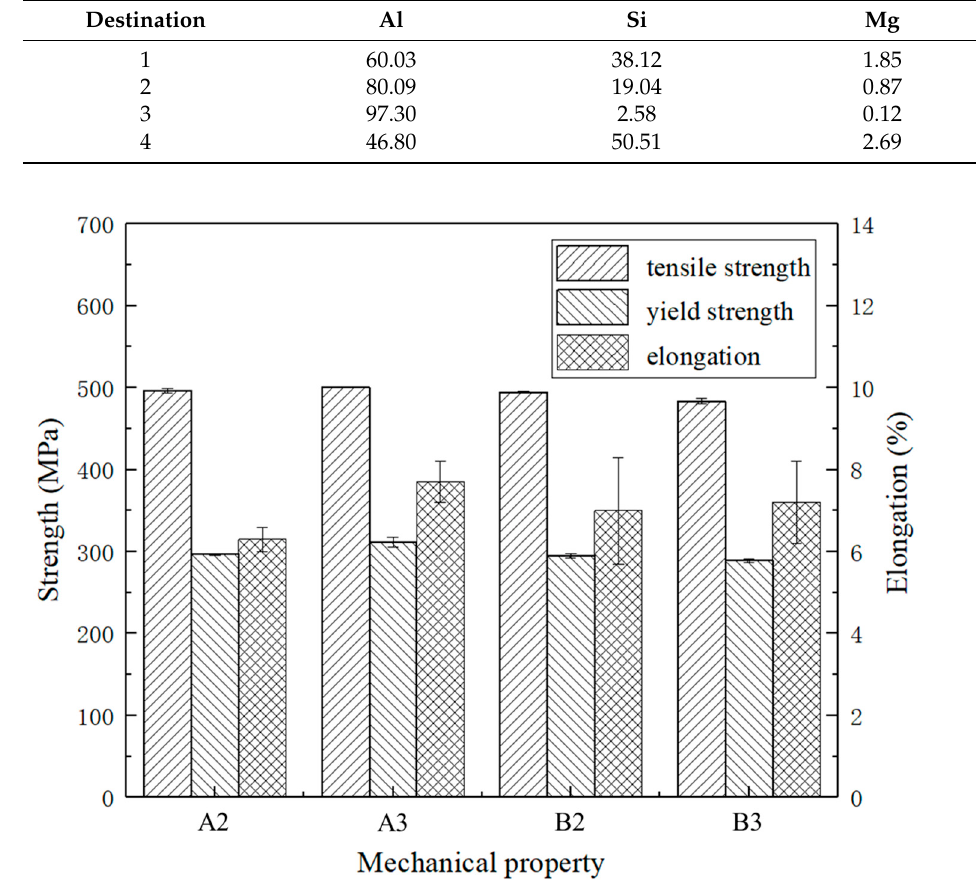
Figure 10. Tensile mechanical properties of A2, A3, B2, and B3 samples in the as ‐ printed status.